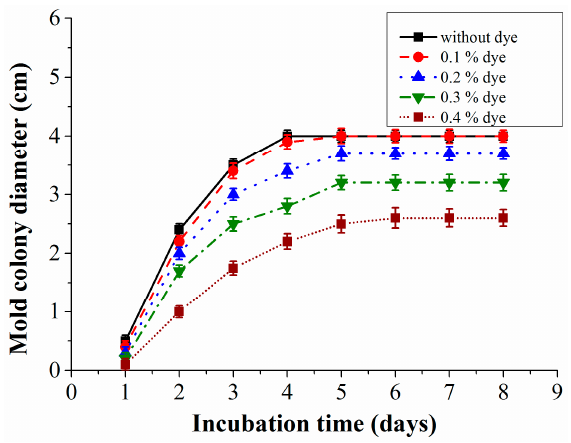
Figure 7. Growth curves of mold species with varied methyl red dye concentrations measured at room temperature (23 ± 1°C).